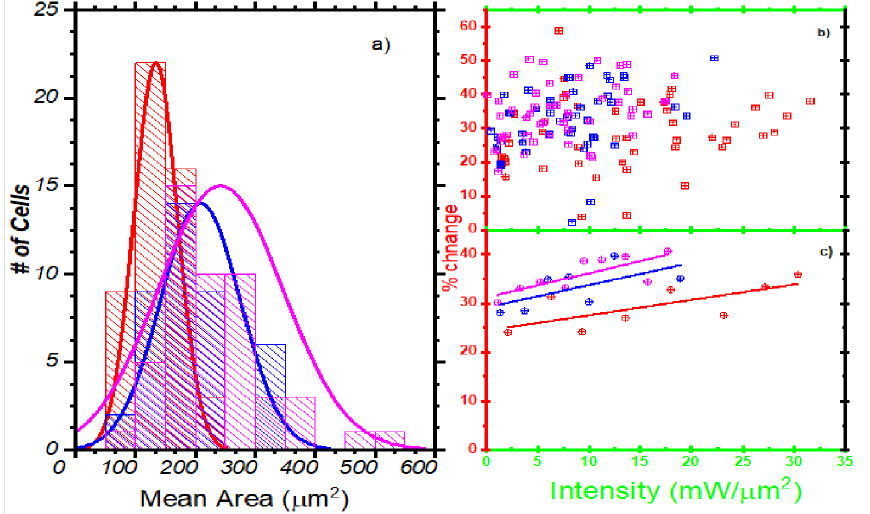
Figure 4. ( a ) Size distribution of the mean area of untreated (red), 3 h treated (blue) and 6 h treated (magenta); ( b ) percent change in the trap cells as a function of the intensity; ( c ) reduced percent change in the cells as a function of the intensity for a trap cell. In all ( a – c ), the traces of the behaviors were made using fourth-order polynomial